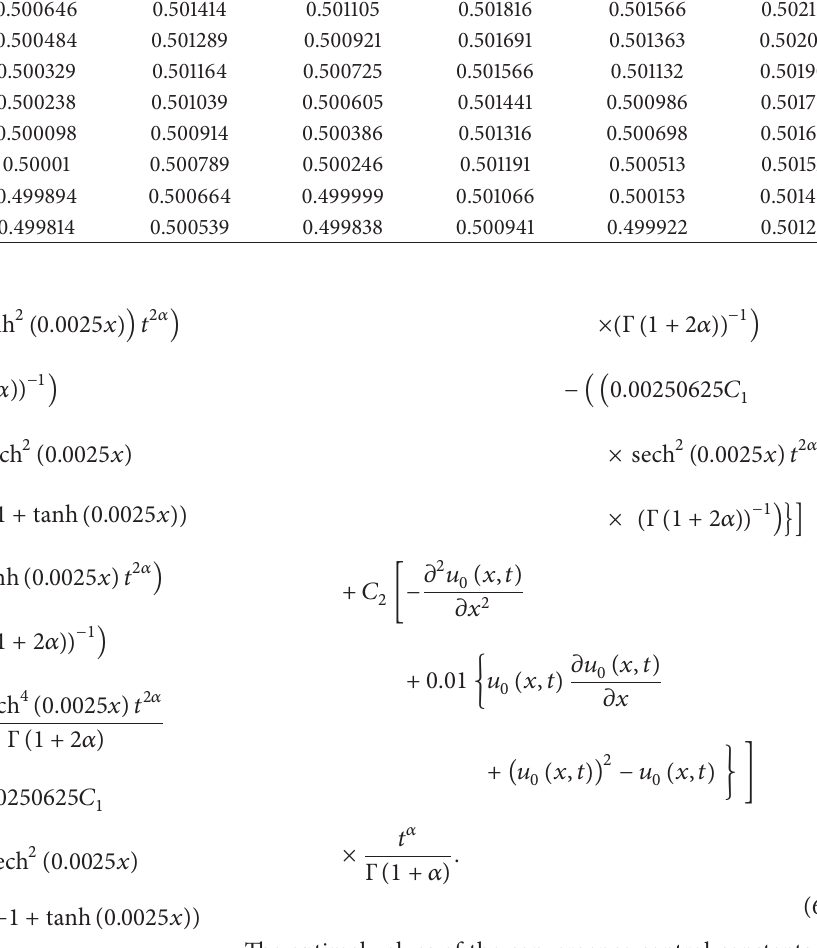
The optimal values of the convergence control constants 𝐶 1 and 𝐶 2 can be obtained using collocation method from